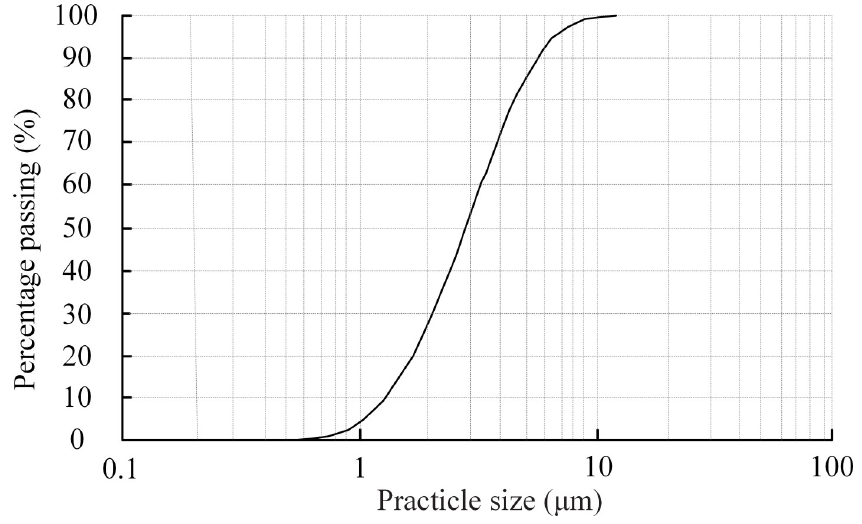
Fig 2. Particle size distribution curve of the kaolin.